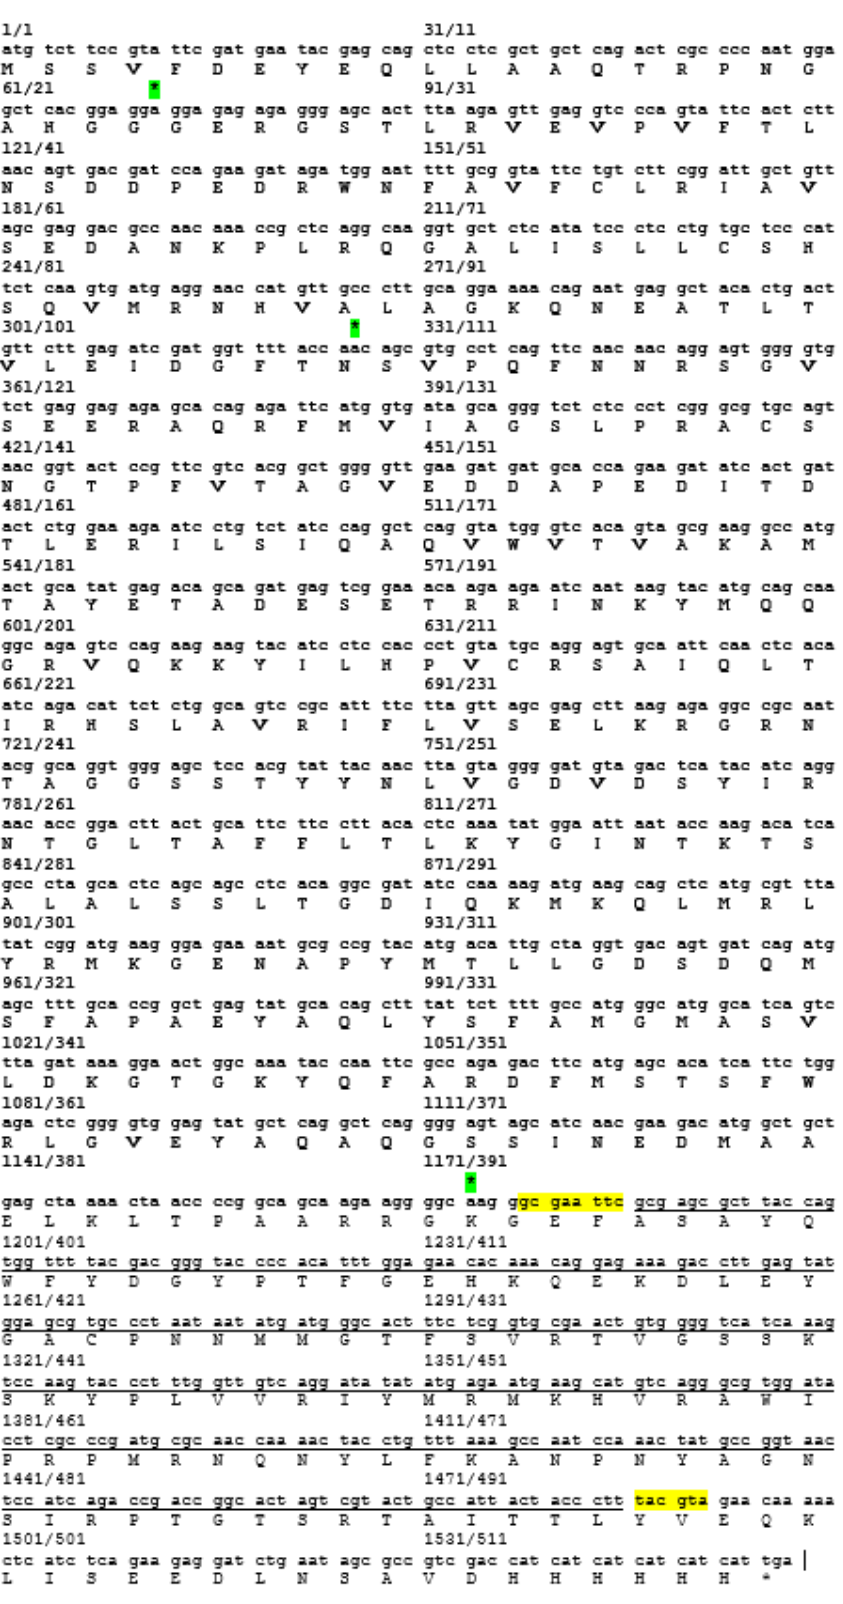
Figure 6. Nucleotide and amino acid sequence of gene encoding for NPt-VP1 198–297. Black color sequence from 1–1177 nucleotide is a NP sequence and VP1 198–297 nucleotide sequence indicates with underline ___ from 1185–1485 seq. The * indicating mutated nucleotide and highlighted text is the restriction enzymes.